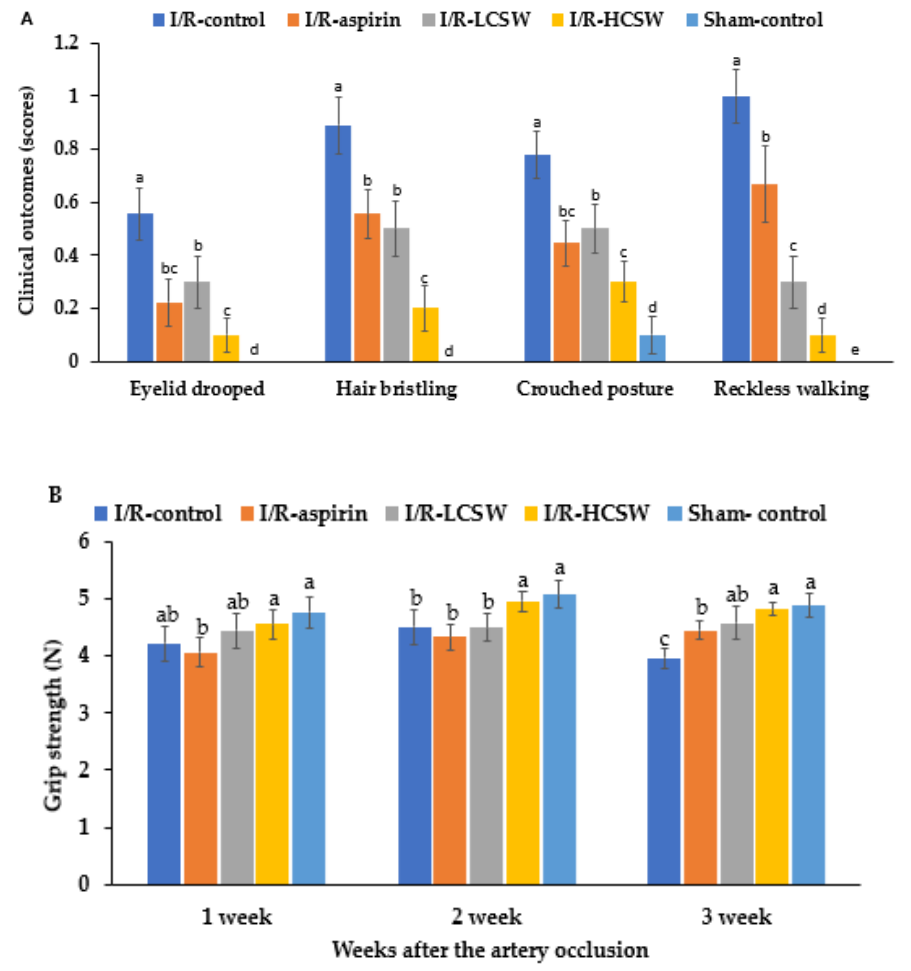
Figure 3. Neurological severity scores. Gerbils that underwent the transient ischemic attack by carotid artery occlusion for 8 min and reperfusion were randomly divided into four groups, as follows: (1) 0.2% cellulose (I/R-control), (2) 0.02% aspirin (I/R-aspirin), (3) 0.05% freeze-dried corn silk water extract (I/R-LCSW), and (4) 0.2% CSW (I/R-HCSW) in a high-fat diet. Sham-operated gerbils without artery occlusion had the same diet as Sham-control. The neurological symptoms, including drooping eyelid, crouched posture, and hair bristling ( A ); flexor reflex, walking patterns, and force to grip the bar ( B ), were shown at the third week after inducing ischemic stroke attack. Bars represent means ± SD ( n = 10). a–e Different letters on the bars indicate significant differences in the means of the designated groups by Tukey’s test at p < 0.05.